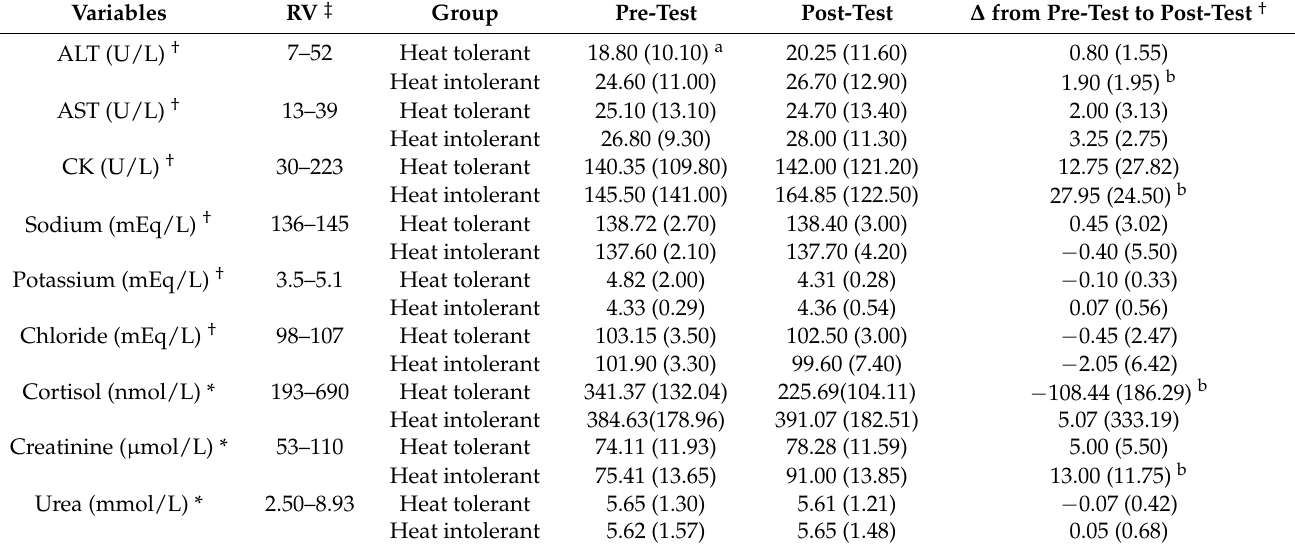
Table 2. Differences in biochemical and hormonal variables between the heat-tolerant and heat-intolerant groups.